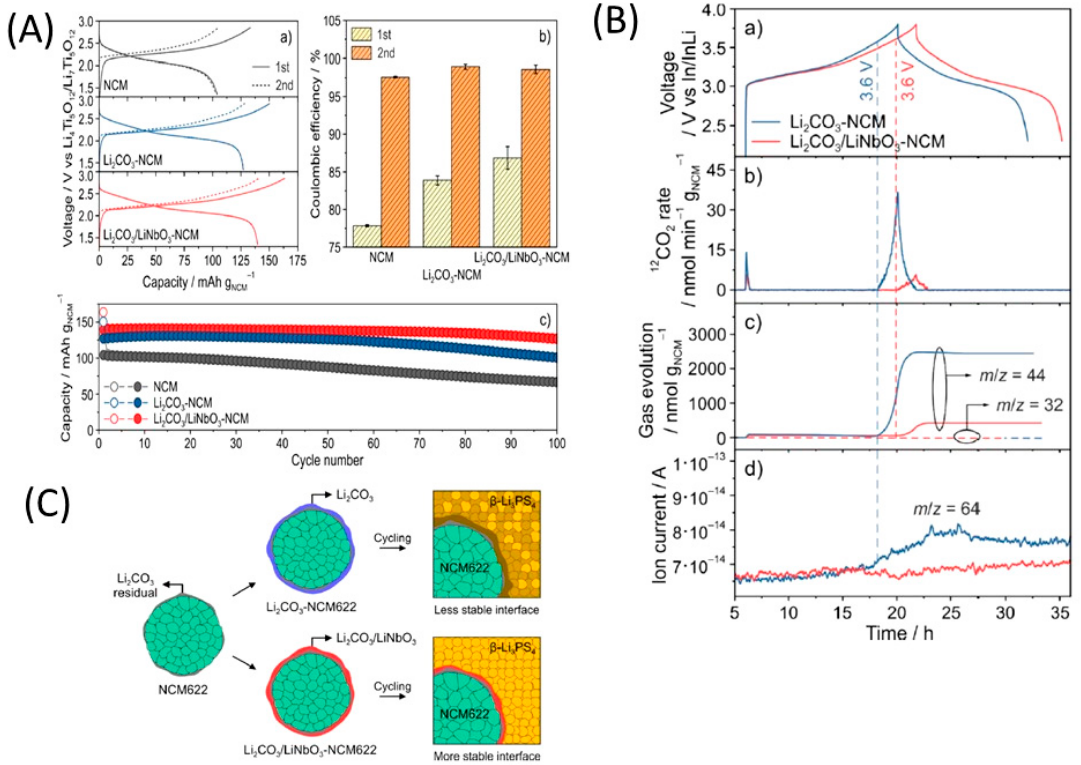
Figure 11. ( A ) ( a ) The 1st and 2nd cycle voltage profiles, ( b ) corresponding Coulombic efficiencies, and ( c ) cycling performance at a rate of C/10 and 25 °C of solid-state batteries (SSBs) using bare (gray), Li 2 CO 3 -coated (blue), and Li 2 CO 3 /LiNbO 3 -coated NMC622 (red) cathodes. In ( b ), the error bars indicate standard deviations. ( B ) ( a ) The 1st cycle voltage profile at a rate of C/20 and 45 °C of